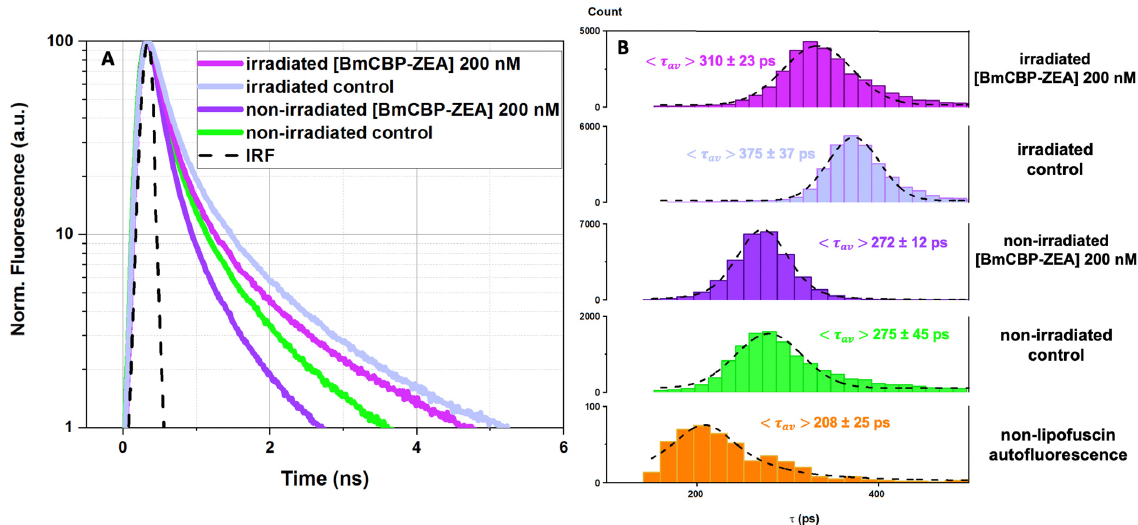
Figure 6. Effect of BmCBP-ZEA on the changes in lipofuscin fluorescence lifetime induced by photo- oxidation with white light irradiation: ( A ) average fluorescence decay curves; ( B ) distribution of fluorescence lifetime in each pixel of the image. Excitation λ exc: 473 nm; detection λ det: 530(40) nm. Average fluorescence lifetime values ( < τ av > ) were obtained by approximation of distributions with the Gauss function (fitting is visualized as dashed line) with errors corresponding to the width of the